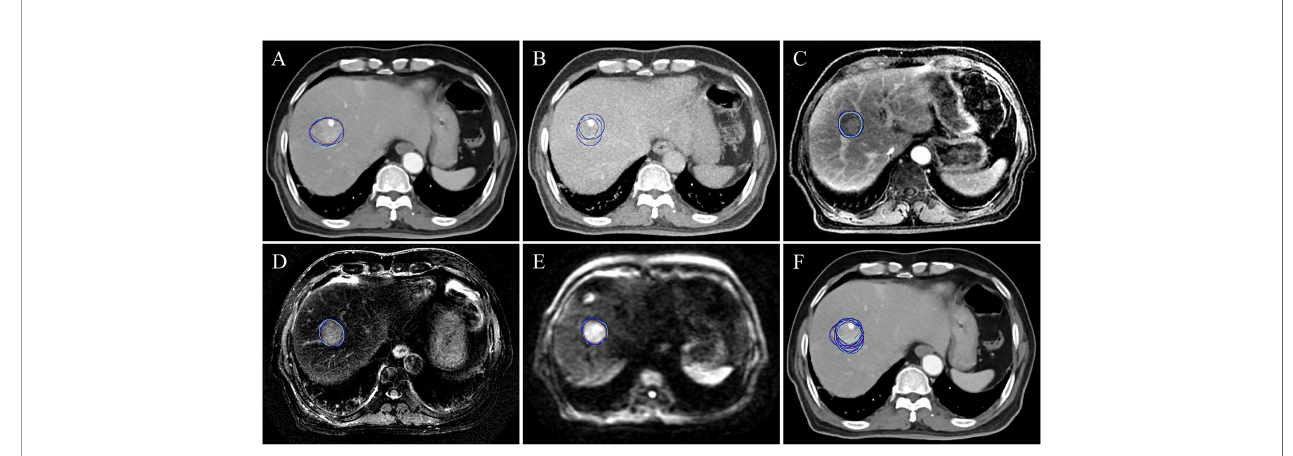
FIGURE 2 | A subject (a male aged 69 and diagnosed with hepatocellular carcinoma) of the target delineation for primary liver cancer in 3D-CT, MIP and multiple- parameter MR images. (A-E) show the delineation results of CECT, MIP, LAVA-Flex, T2W FRFSE and DWI-EPI, respectively. (F) shows all the delineation results displayed on CECT. The blue, brown, cyan and dark blue contour denote the fi rst delineation of the fi rst observer. The brown contour is the second delineation of the fi rst observer. The cyan contour is the fi rst delineation of the second observer. The dark blue is the second delineation of the second